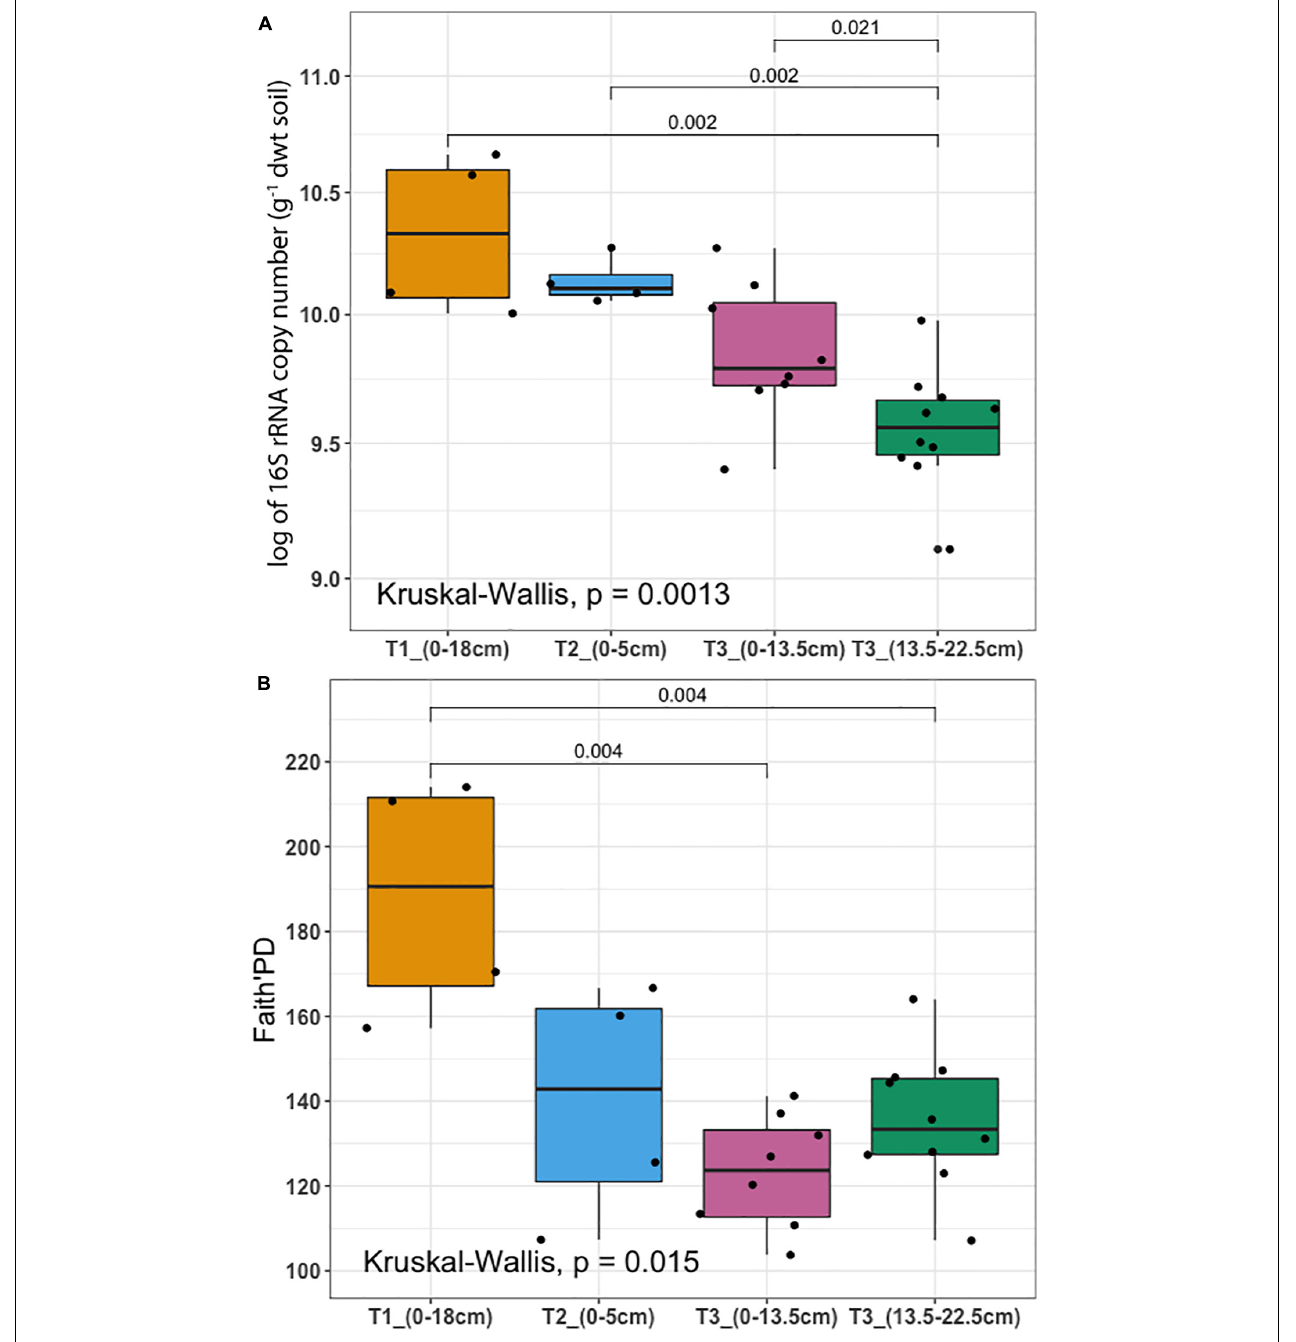
FIGURE 3 | Microbial biomass and diversity analysis (A) 16S rRNA gene copy number per gram of dry weight soil assessed by qPCR ( y -axis was logarithmically transformed). (B) Faith’s Phylogenetic Diversity (Faith’s PD). Samples were collected from three terraces with different depths: T1_(0–18 cm) (yellow), T2_(0–5 cm) (blue), T3_(0–13.5 cm) (pink), and T3_(13.5–22.5 cm) (dark green). In each box plot, a point denotes a single soil sample. The top and bottom of each box represent the 25th and 75th percentiles, the horizontal line inside each box represents the median and the whiskers represent the range of the points excluding outliers. Differences between terraces were evaluated using the Kruskal-Wallis analysis of variance, followed by post hoc Mann-Whitney-Wilcoxon test pairwise differences.